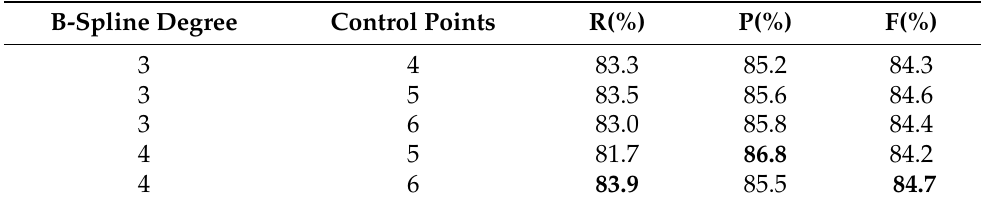
Table 1. Ablation studies: The effect of the degree of B-Spline and the number of control points on the detection